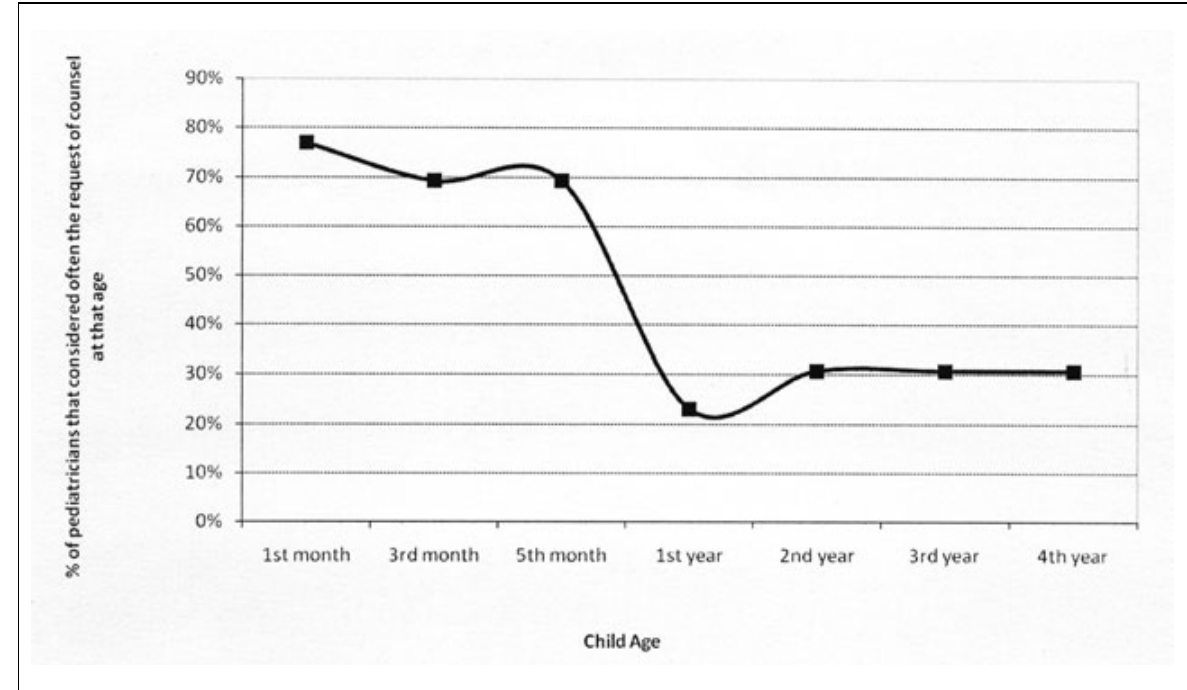
Figure 5. Age of children when mothers ask more advice (according to